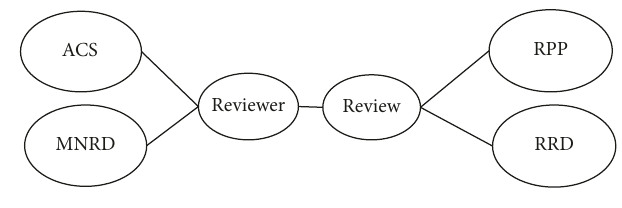
Figure 2: Network pattern based on the feature list { ACS, MNRD, RPP, RRD } .